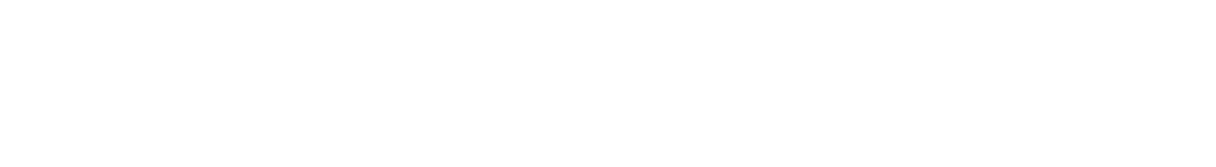
Frontiers in Bioengineering and Biotechnology |